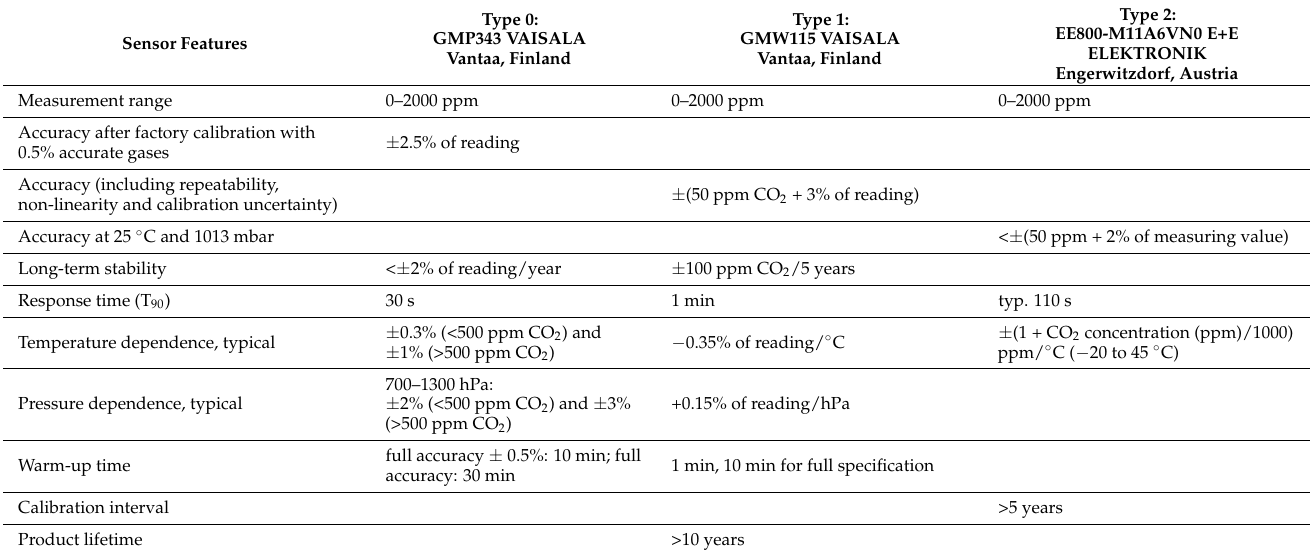
Table 1. Types of sensors used in this analysis and summary of their